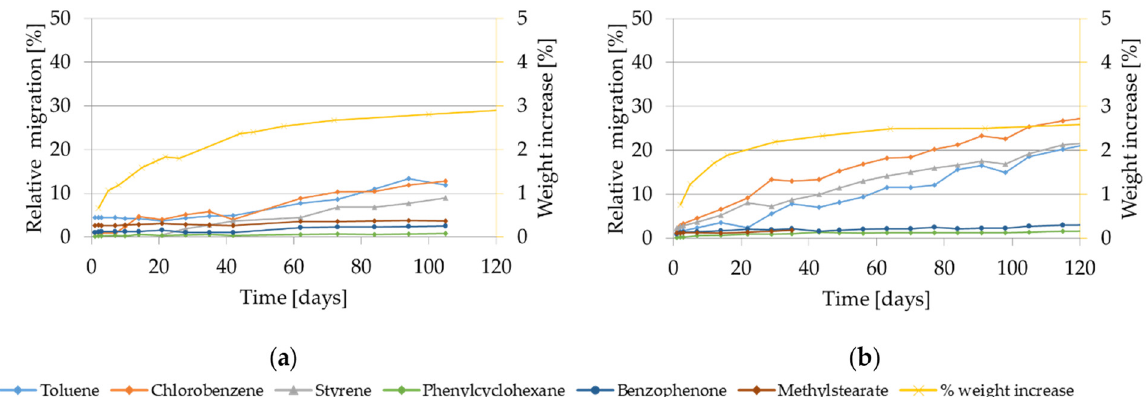
Figure 6. Migration and weight increase in 95% ethanol at 20 °C: ( a ) Model substances and styrene from GPPS; ( b ) Model substances and styrene from HIPS.